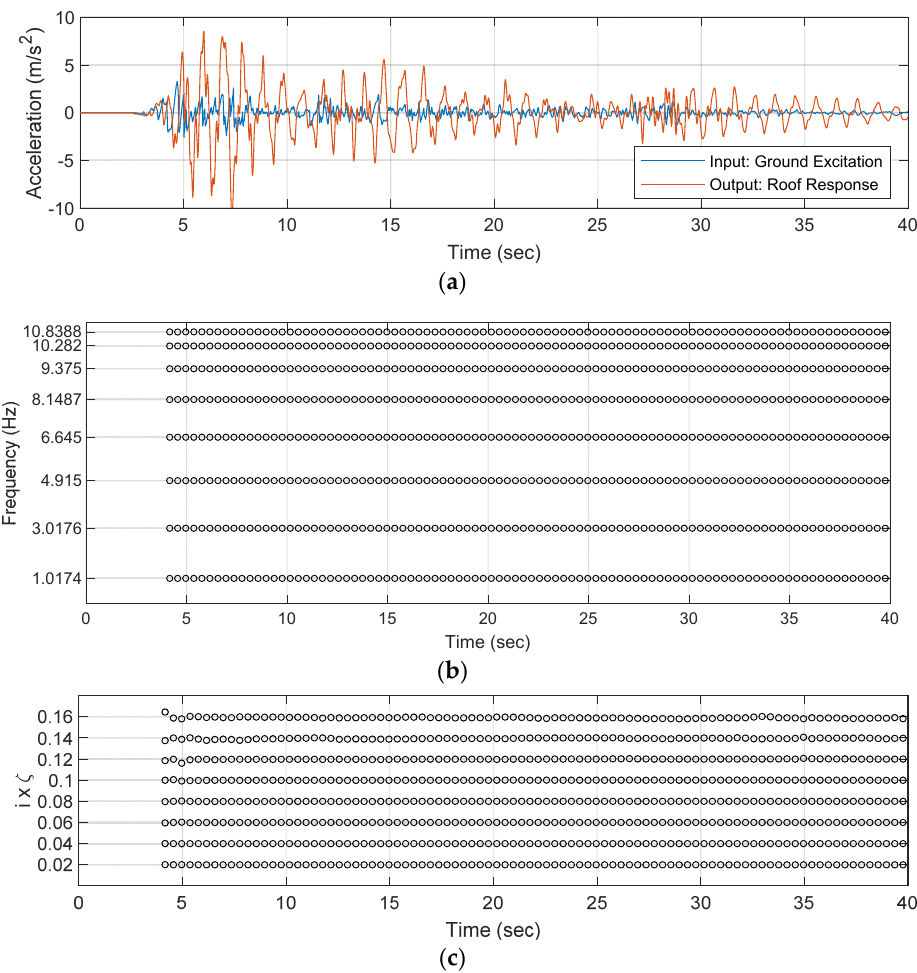
Figure 3. The identified modal parameters under the seismic excitation. ( a ) Ground excitation and structural responses; ( b ) identified frequency over time; ( c ) identified damping ratio over time.